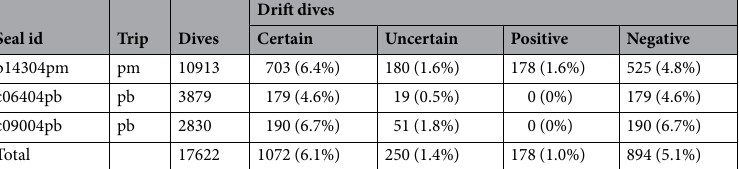
Table 1. Number of high-resolution time-depth recorder (TDR) dives used for the development of the drift dive methodologies. Shown are the numbers of dives visually classified as drift dives; either as certain or uncertain. Certain drift dives are indicated as positive (i.e. upward drift segment) or negative (i.e. downward drift segment). Trip types are indicated as post-moulting (pm) or post-breeding (pb). Numbers in parentheses give percentages.